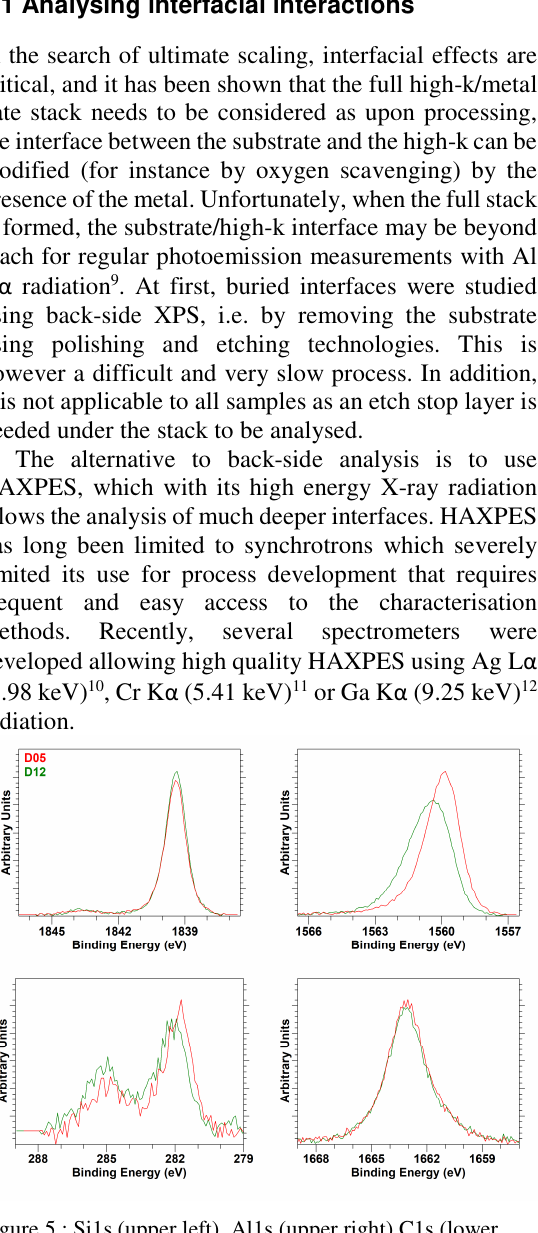
Figure 5 : Si1s (upper left), Al1s (upper right) C1s (lower left) and Hf 3d 5/2 (lower right) HAXPES spectra of a ~12 nm thick TiN/TiAlC/TiN/HfO 2 /SiO 2 stack on Si substrate,